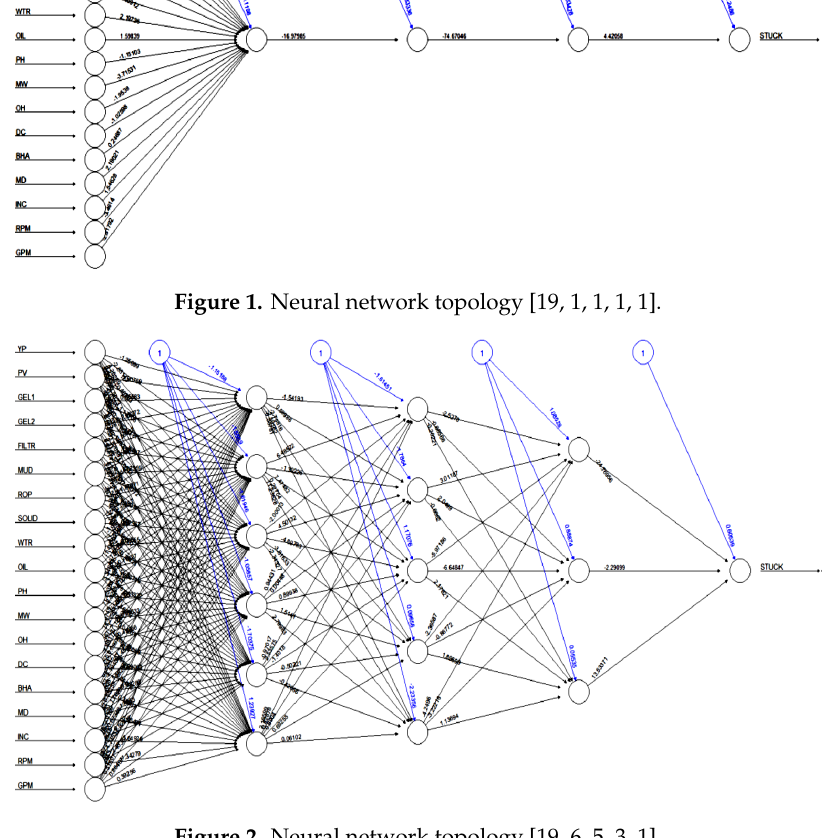
Figure 2. Neural network topology [19, 6, 5, 3, 1]. Energies 2020 , 13 , x FOR PEER REVIEW